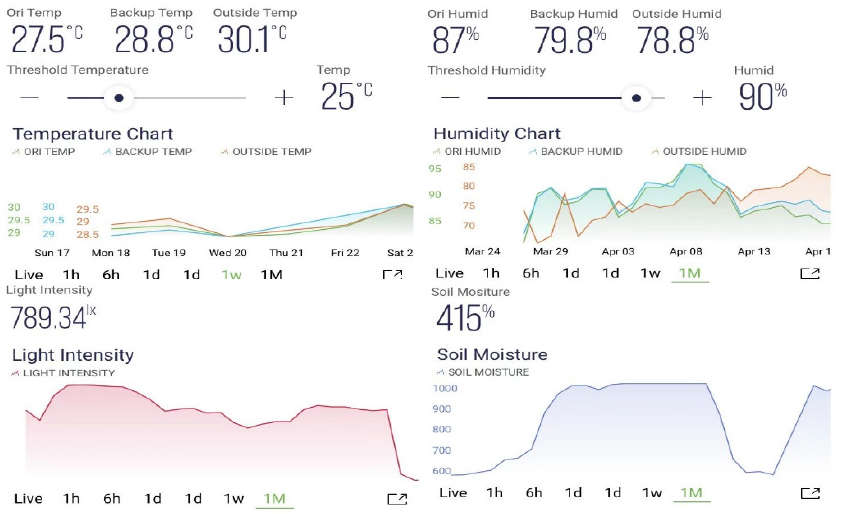
Figure 7. The user interface of the application dashboard presenting the real time status of different conditions in the mushroom cultivation chamber.